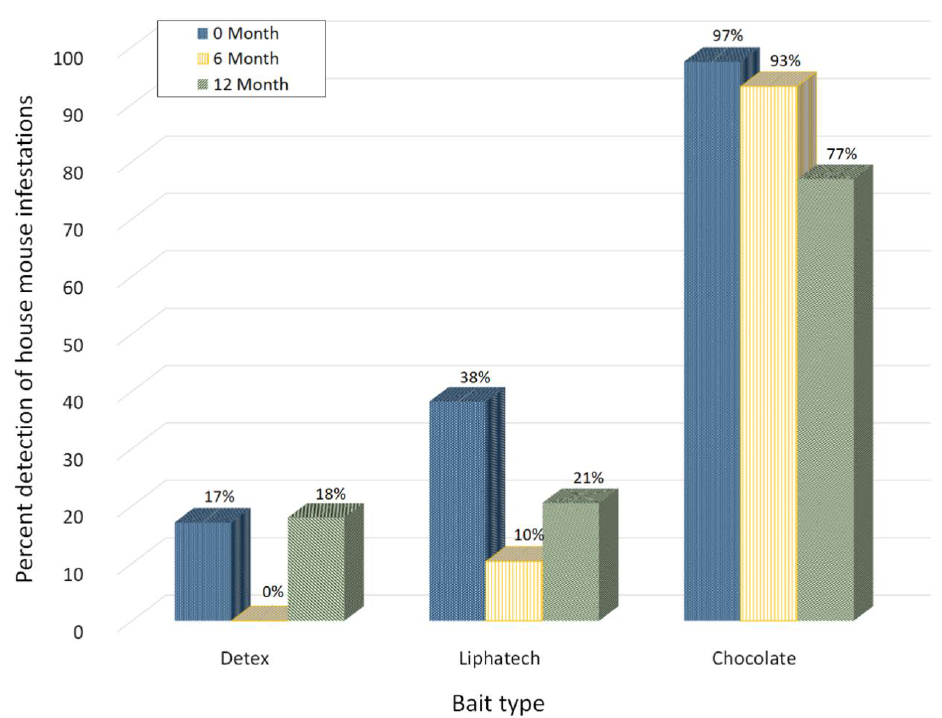
Figure 5. The percent of detection of house mouse activity by three different non-toxic baits during building-wide inspec- tions. Table 2. Comparison of feeding activity on chocolate spread and two commercial non-toxic baits during the 12 month study.